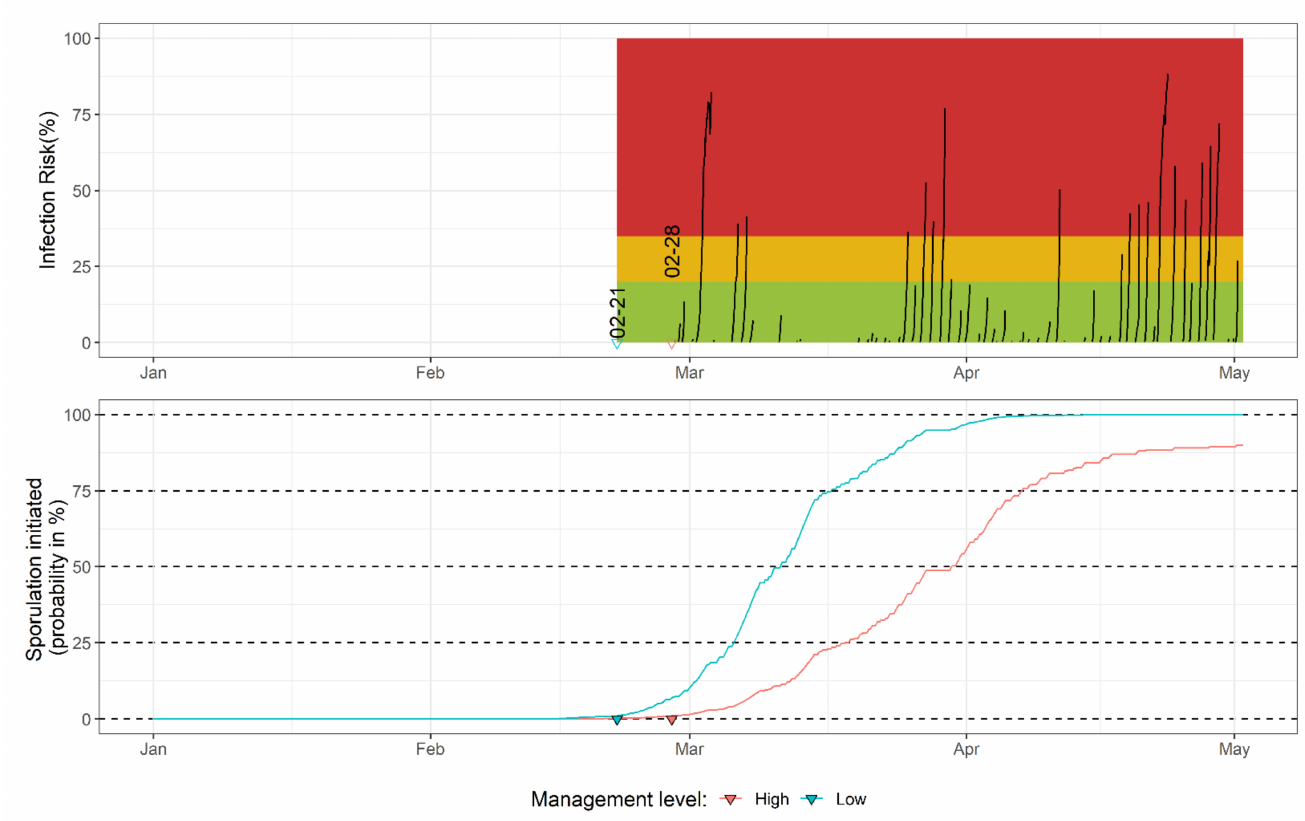
Figure 7. The mummy berry DSS developed in northwestern Washington blueberry fields with low- or high-management levels for the disease. The upper graph represents the percentage of infection risk, where the green, orange and red areas represent the low, medium and high level of risk, respectively. The dates (formatted as: month-day) above triangles correspond to a 1% probability of apothecial presence in the field in two management systems. The lower graph presents the probability of apothecial